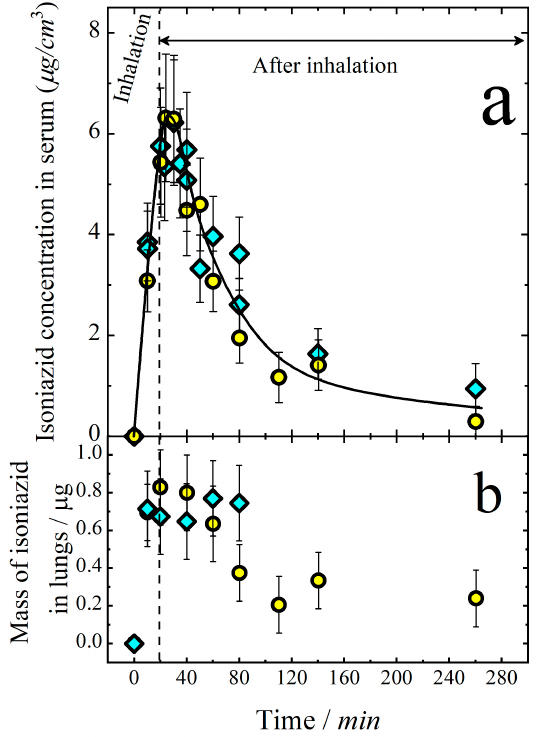
Figure 3. Isoniazid concentration in serum ( a ) and its mass in lungs ( b ) vs. time during and after inhalation. Solid line is an eye guide. Vertical dash line marks the termination of inhalation at time 20 min. The inhalation dose at the end of exposition is 9 mg/kg. Diamonds and circles refer to the expositions in WB and NO inhalation chambers, respectively.